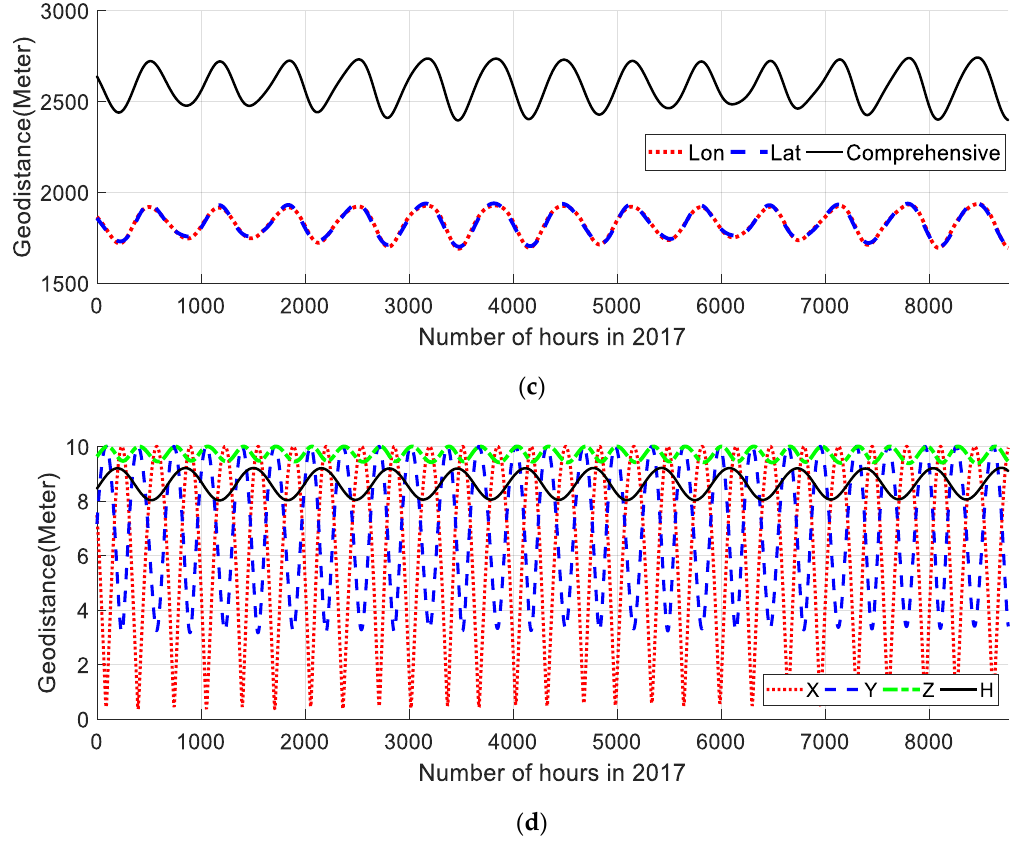
Figure 8. Pointing errors caused by the ( a ) attitude error, ( b ) libration error, ( c ) seleno-graphic error with a magnitude of one second, and ( d ) lunar center error and elevation error with a magnitude of 10 m. The sensor is located at (−60,0) and is pointed to the geocenter. Table 2. The max and min geo-distance deviation (meters) derived from one second sensor attitude or seleno-graphic coordinate errors over the past 50 years when the line of sight (LOS) is pointed to the geocenter. The simulation step size is one day. The deviations caused by the librations and lunar center coordinates given by DE430 are consistent with Figure 8 and are therefore not shown in this Table.